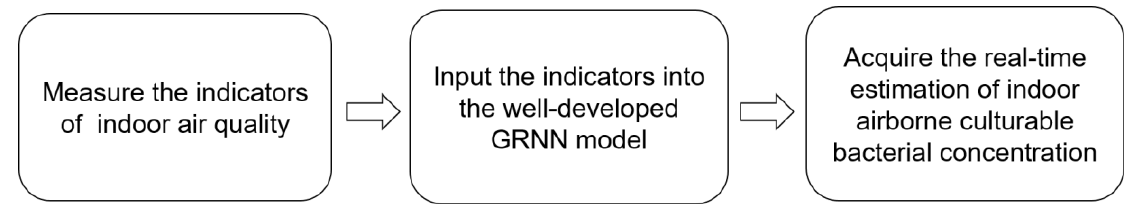
Figure 4. A proposed framework for the real-time estimation of the concentration of indoor airborne culturable bacteria.